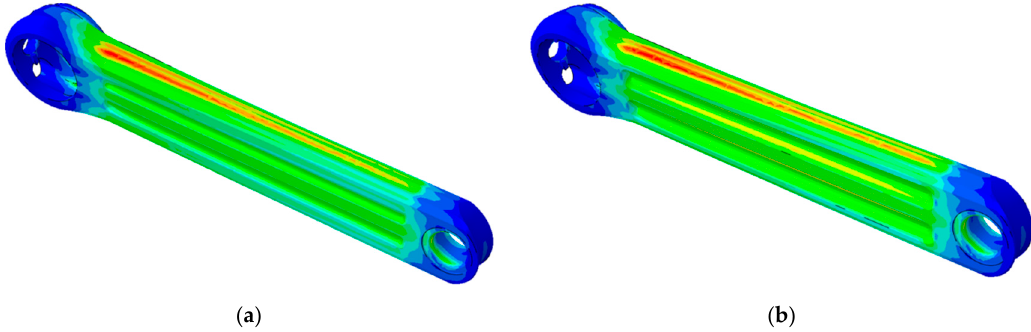
Figure 21. Comparison of the stress distribution map between: ( a ) the original model and ( b ) the new model.